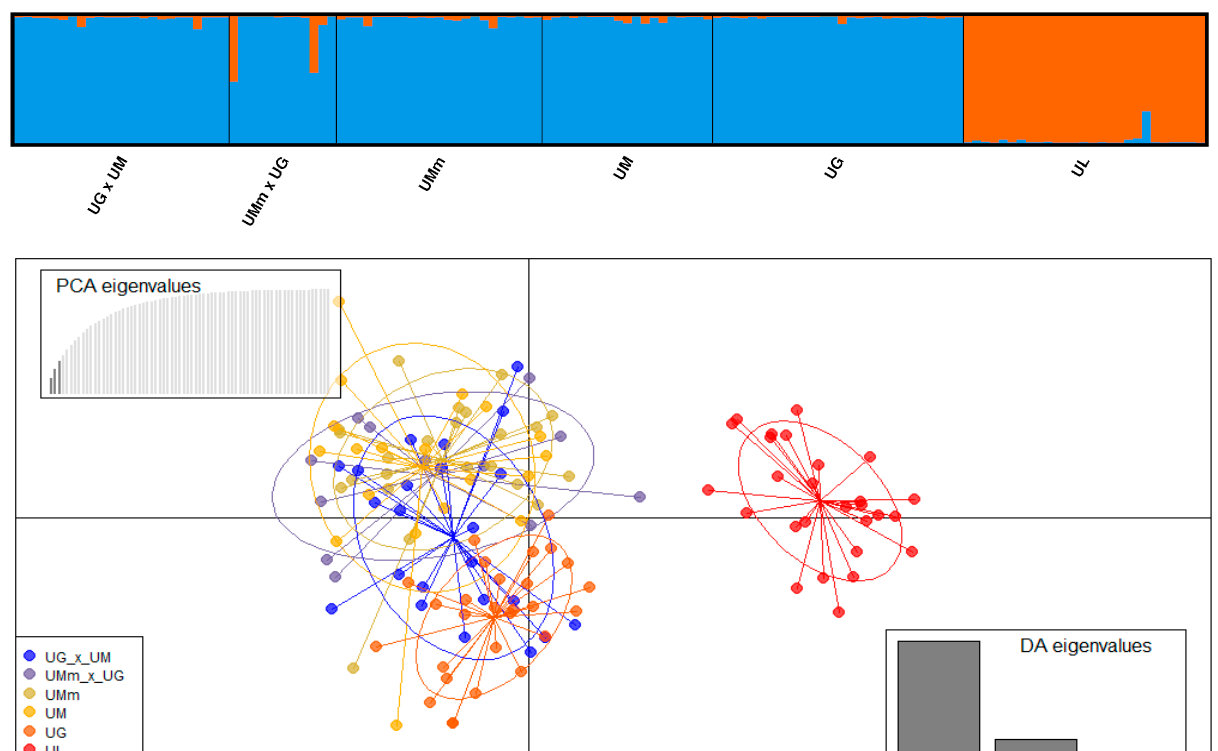
Figure 4. The upper plot: differentiation of elm species based on Bayesian admixture clustering with K = 2 (highest delta K value of 261.6 was for K = 2; Table S2 and Figure S5). In the plot, everything is represented by a thin vertical line divided into K = 2 colored segments that represent the individual’s estimated membership fractions. The black vertical lines separate the species groups. The lower plot: discriminant analysis of principal components (DAPC) of six Ulmus spp. groups based on eight microsatellite markers. The graph shows the individuals as dots and the groups as inertia ellipses. Eigenvalues of the PCs are displayed in the upper left bar chart (R package adegent 2.0.0) [64,65].